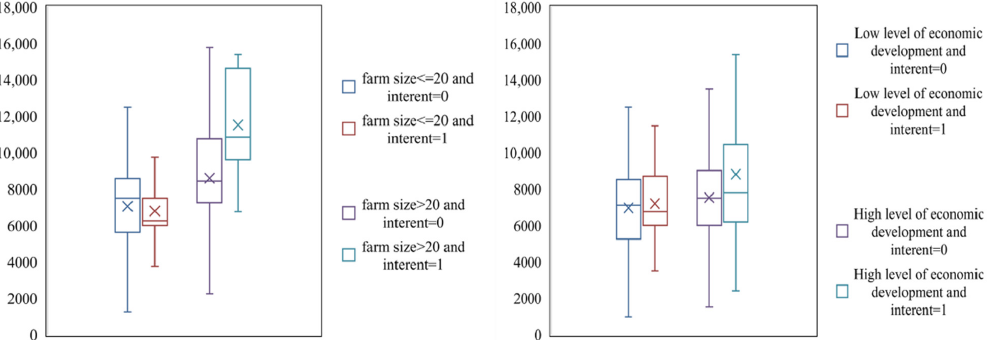
Figure 3. Grain production of Internet-using farmers and non-Internet-using farmers under different farm size and economic development levels .